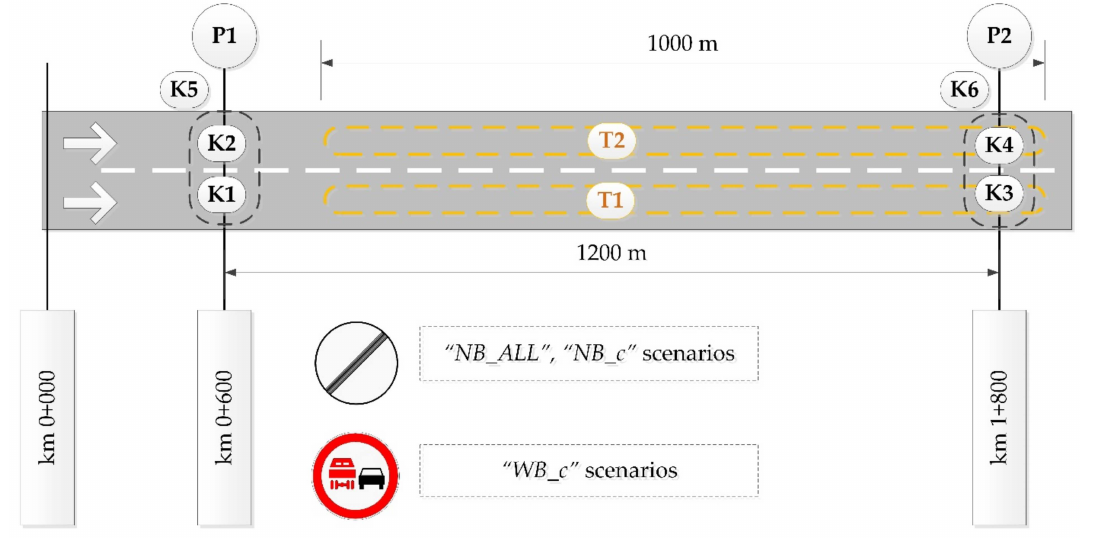
Figure 5. Schema of unidirectional carriageway in the simulation traffic